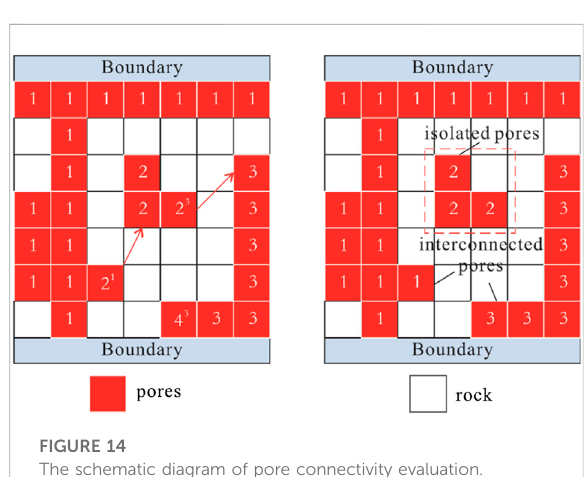
FIGURE 14 The schematic diagram of pore connectivity